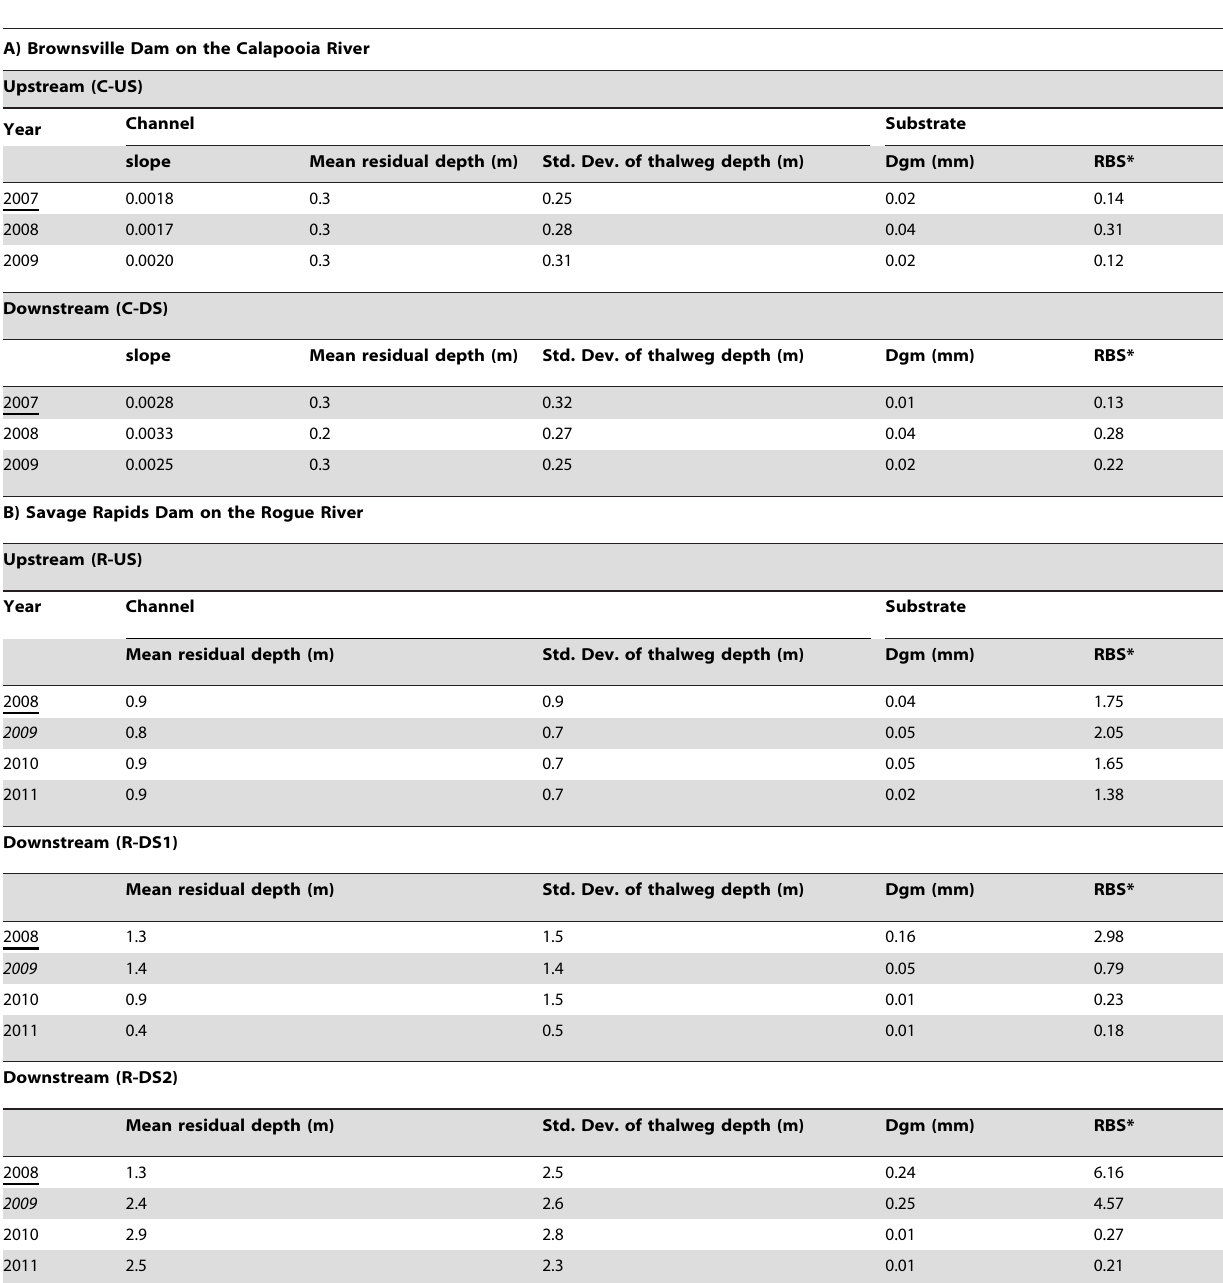
Table 2. Geomorphic measures of disturbance from the sediment